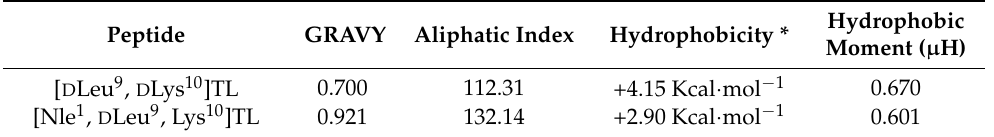
Table 1. Physicochemical properties of [Nle 1 , D Leu 9 , D Lys 10 ]TL in comparison with its